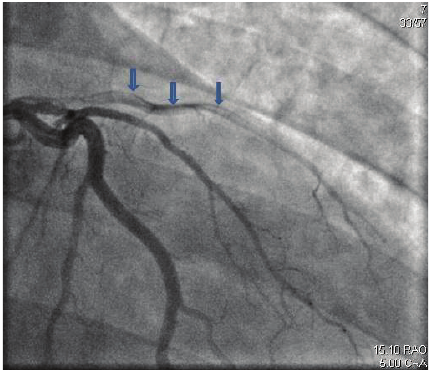
Figure 3: Showing total left anterior descending spontaneous